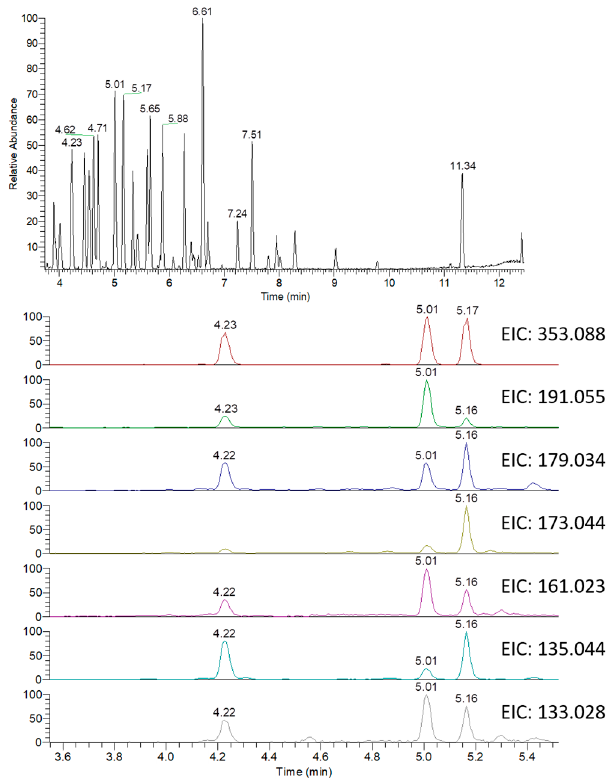
Figure 1. Base peak chromatograms (BPC) and extracted ion chromatograms (EIC) of the peak at m / z representing caffeoylquinic acid isomers from the Hibiscus extract measured in the negative ionization mode.